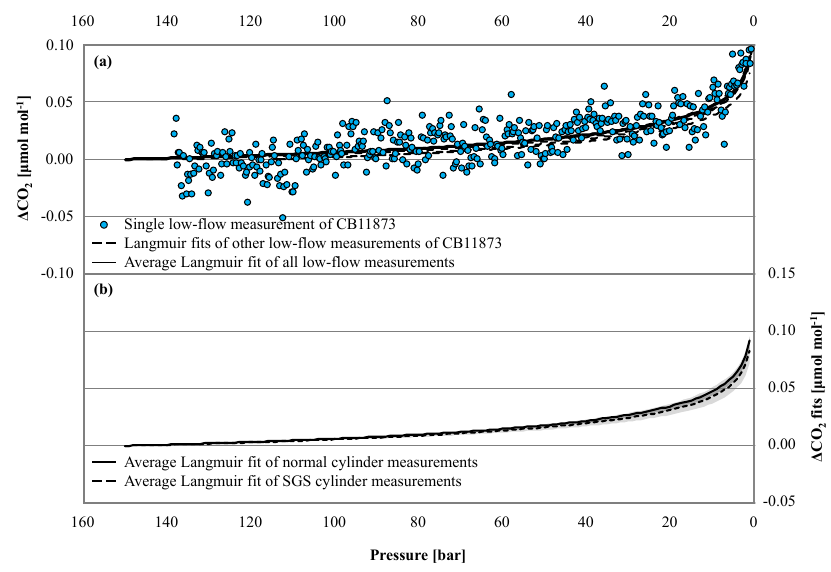
Figure 6. (a) The blue circles represent the CO 2 mole fraction measurement of a low-flow experiment started on 17 October 2016 with CB11873 vertically positioned as a function of pressure; note the inverse pressure scale. The black dashed lines are the individual fits following the Langmuir model of the other low-flow experiments done with CB11873 vertically positioned; the black solid line represents the average Langmuir fit using all low-flow experiments with the cylinders vertically positioned. (b) The black solid and dashed lines correspond to the average Langmuir fit of all normal and SGS cylinder measurements, respectively, that were done under low-flow conditions; the greyed area corresponds to the standard deviation of the averages. In order to plot all data in one plot, the corresponding ( X CO subtracted from the measurements and the fits in both